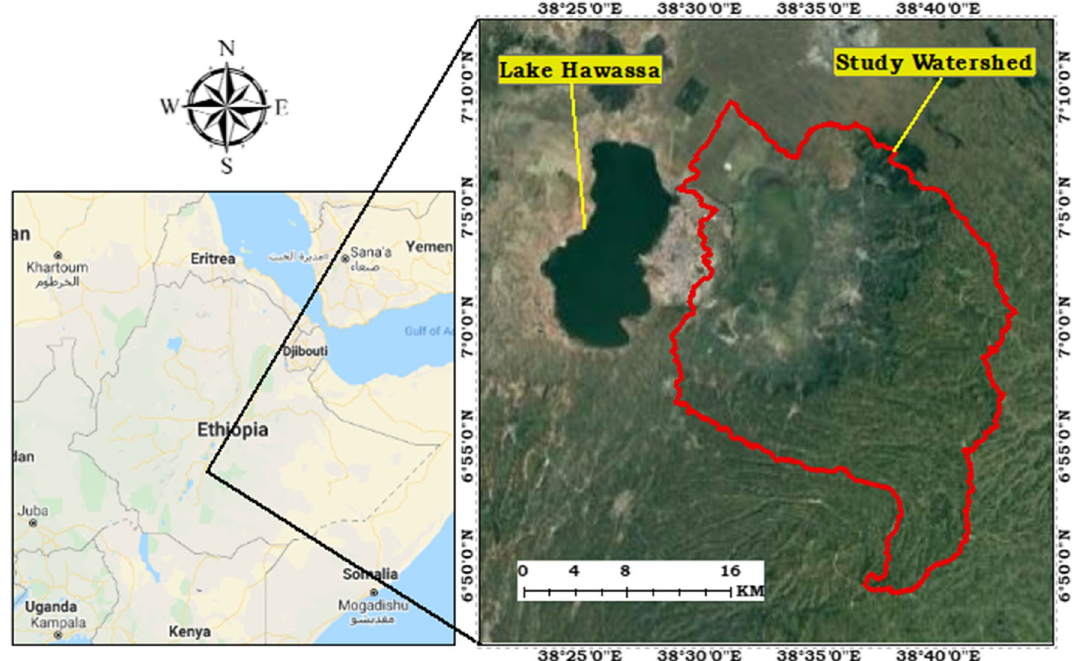
Fig. 1 Location map of Tikur Wuha river watershed (satellite